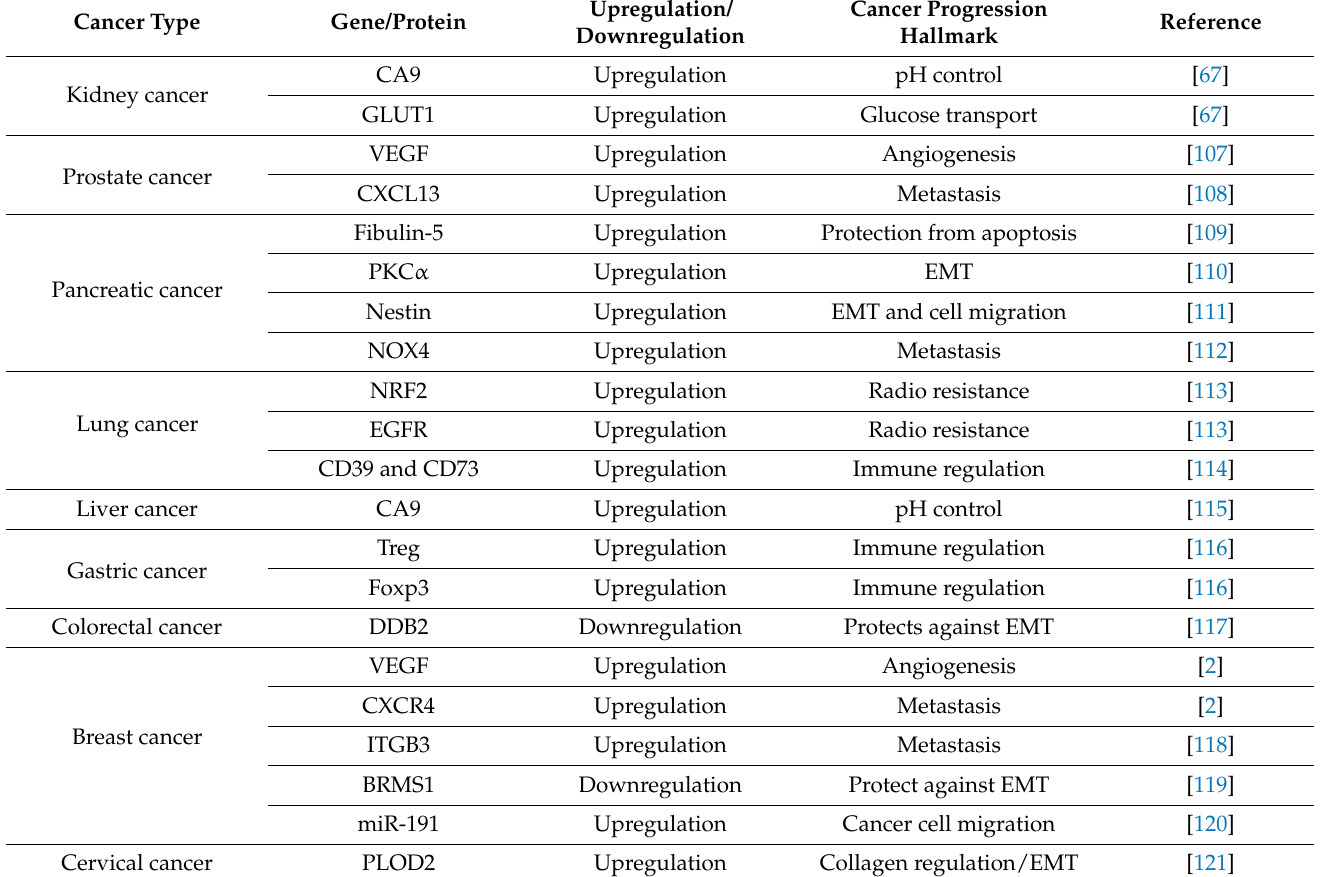
Table 1. Tabulation of selected genes and proteins in different forms of cancer regulated by synergistic cooperation between TGF- β and hypoxia; and specific characteristics associated with them. See also Figure